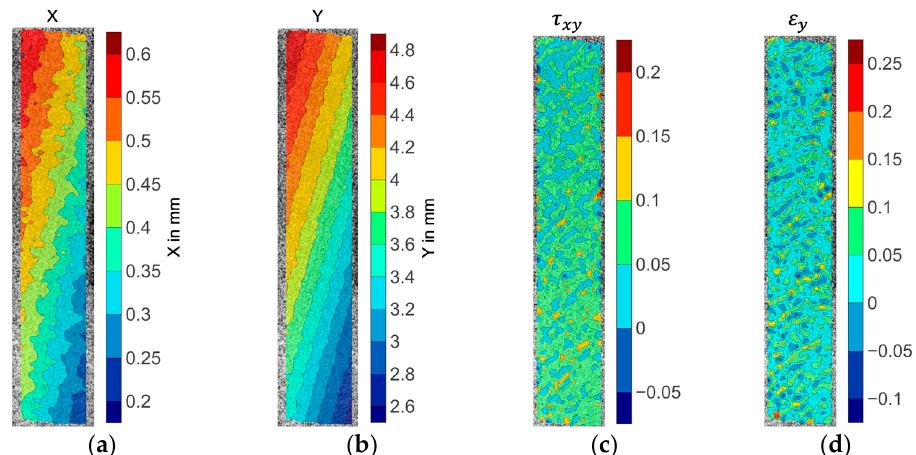
Figure 8. Representative DIC displacement and strain fields of 15° off-axis tension specimen: ( a ) X direction displacement field; ( b ) Y direction displacement field; ( c ) Shear strain field; ( d ) Tension strain field.